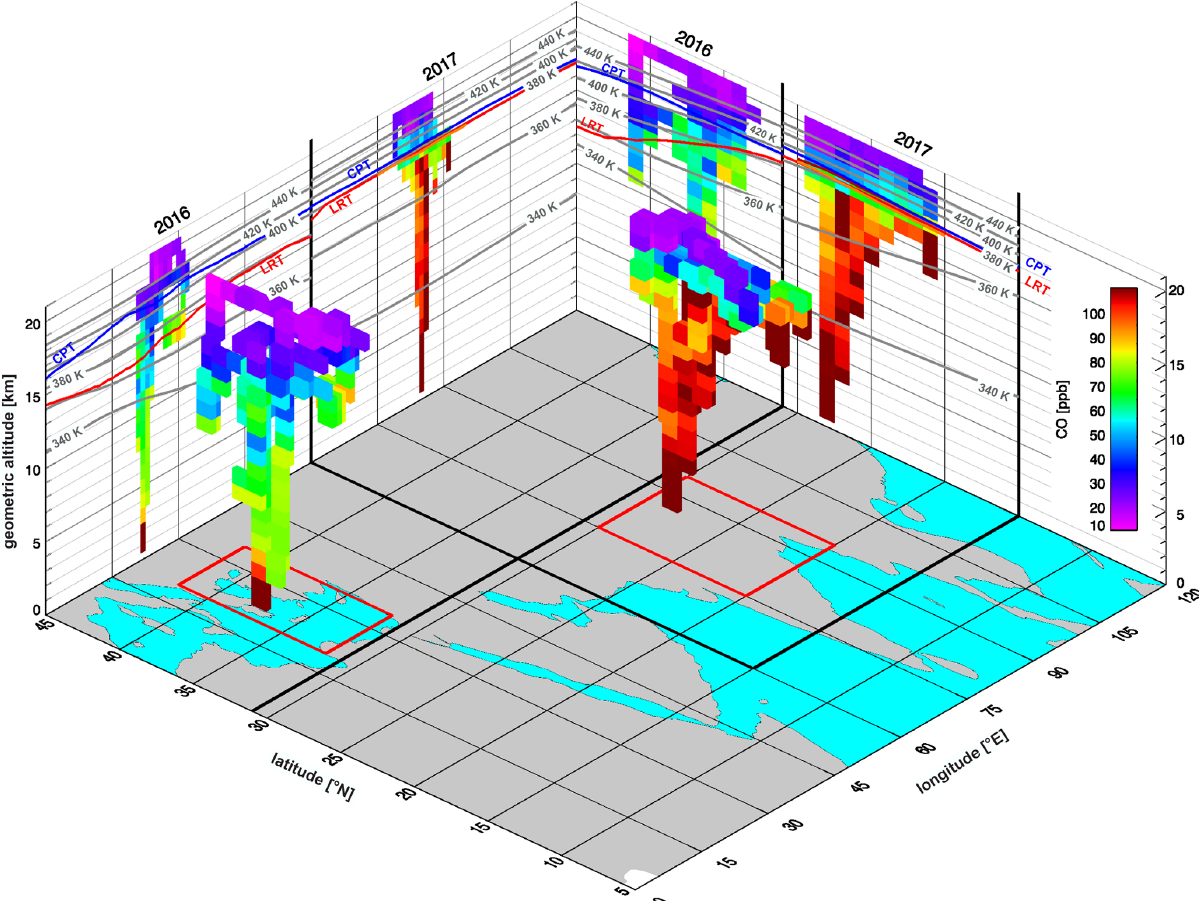
Figure 2. A 3D map of averaged CO mixing ratios observed during all StratoClim flights (raw CO profiles for all individual flights are shown in the Supplement Fig. S1). Values in 3D space represent averages in 1 ◦ × 1 ◦ × 1km longitude–latitude–altitude bins. Longitude–altitude averages over all latitudes and latitude–altitude averages over all longitudes are projected onto the x – z and y – z planes, respectively. Grey contour lines in the x – z and y – z planes show potential temperature levels averaged meridionally and zonally over the areas marked on the map by the thick black lines; red and blue lines show LRT and CPT heights averaged over the same areas (based on ERA-Interim reanalysis products during the respective campaign